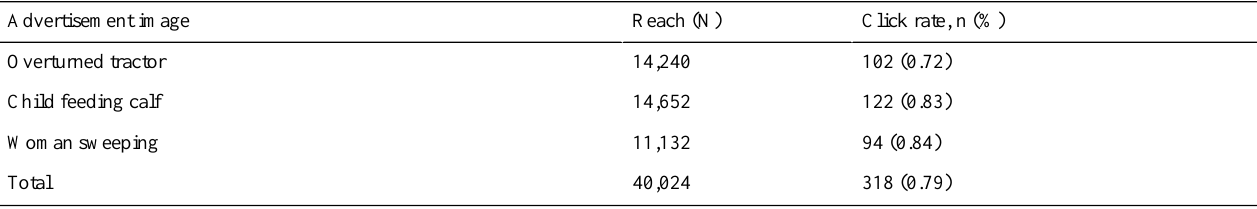
Table 1. Reach and click rate of advertisement images.